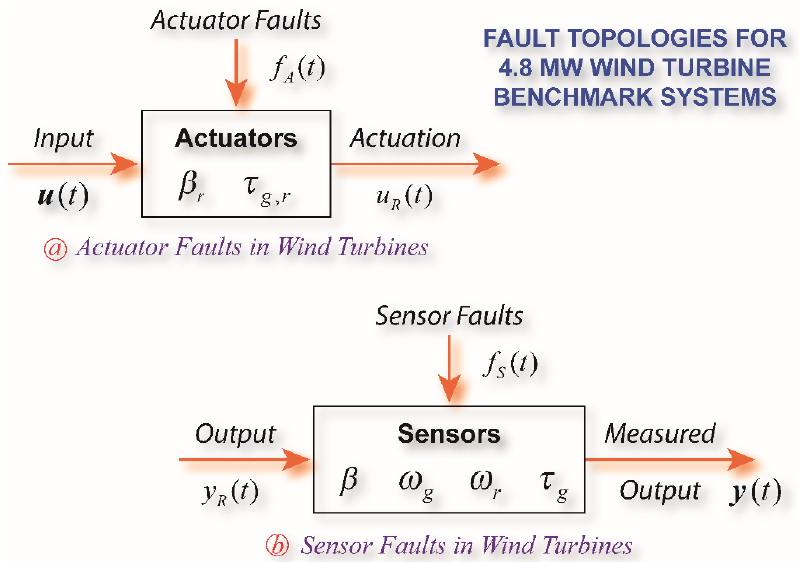
Figure 4. Topologies of the faults in the 4.8 MW wind turbine benchmark system: ( a ). Actuator faults, and ( b ). Sensor faults, respectively.